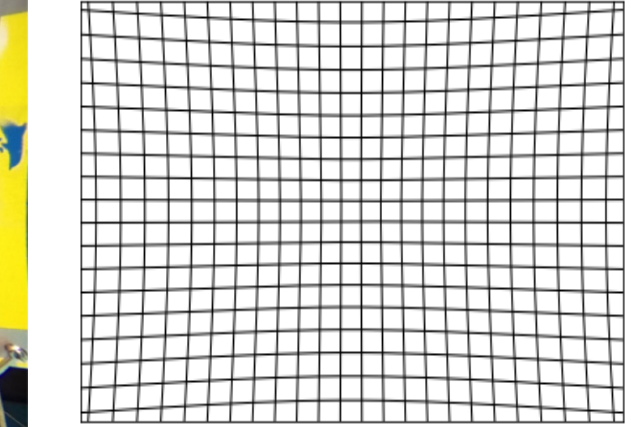
pattern, while the red are the fitted ones ( left ). Effect of the KOSMOS system on a regular grid ( right ).